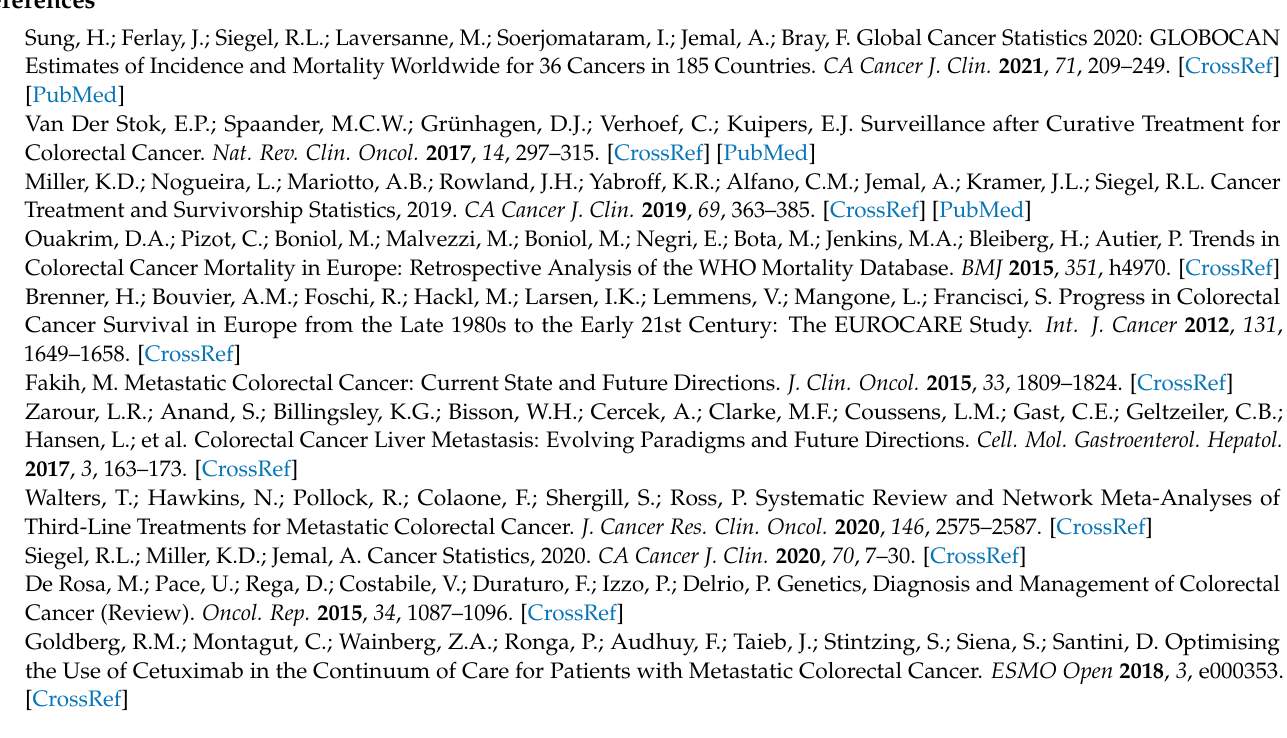
Figure S16: Spiperone induces autophagy and mTOR pathway inhibition; Figure S17: Spiperone treatment alters mitochondrial respiration; Figure S18: Lipidomic results in CRC cells treated with spiperone for 20 and 40 h; Figure S19: Representation of the relative percentage (%) of the major lipid classes identified by HPLC–MS/MS; Figure S20: Western blot membranes; Table S1: RNA-Seq analysis p -value adjusted and log2FC values of the 158 common DEGs; Table S2: Lipidomic analysis of spiperone-treated CRC cells; Table S3: Fisher Exact